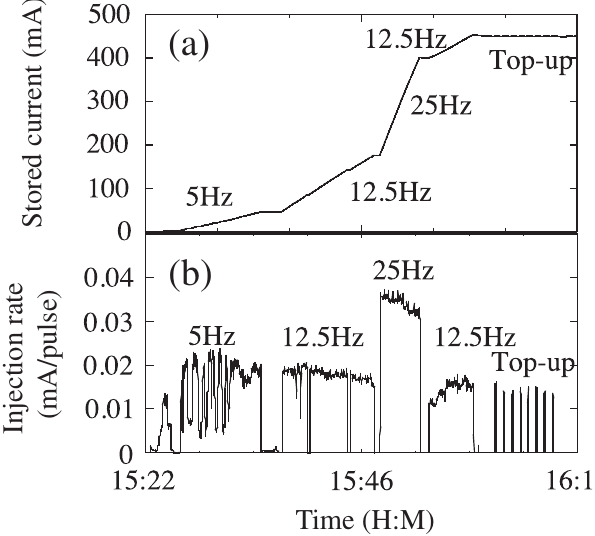
FIG. 18. Progress of the stored beam current is shown in (a) and the injection rate in (b). The beam was injected using the PSM injection (5 and 12.5 Hz) and the pulsed bump injection (25 Hz). Since the injection rate is represented by the injected beam current per an injection pulse, the injection rate can be compared directly between two injection